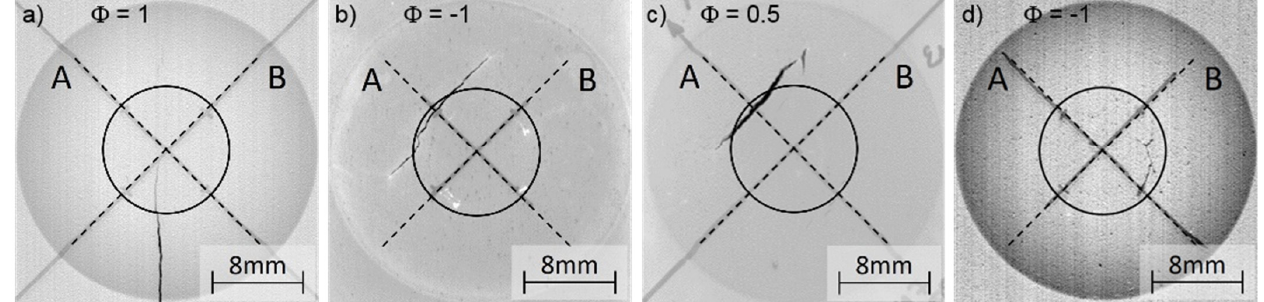
Figure 6: Surface cracks after biaxial fatigue of steel PM 16-7-6 with strain ratios of a)  = 1 (equibiaxial loading), b)  = -1 (shear loading) and c)  = 0.5 at Δ  vM /2 = 0.4 · 10 -2 (a, b, c) as well as d)  = -1 at Δ  vM /2 = 0.5 · 10 -2 , obtained by electron beam monitoring of the gauge area indicated by circles, loading axes A and B marked. 